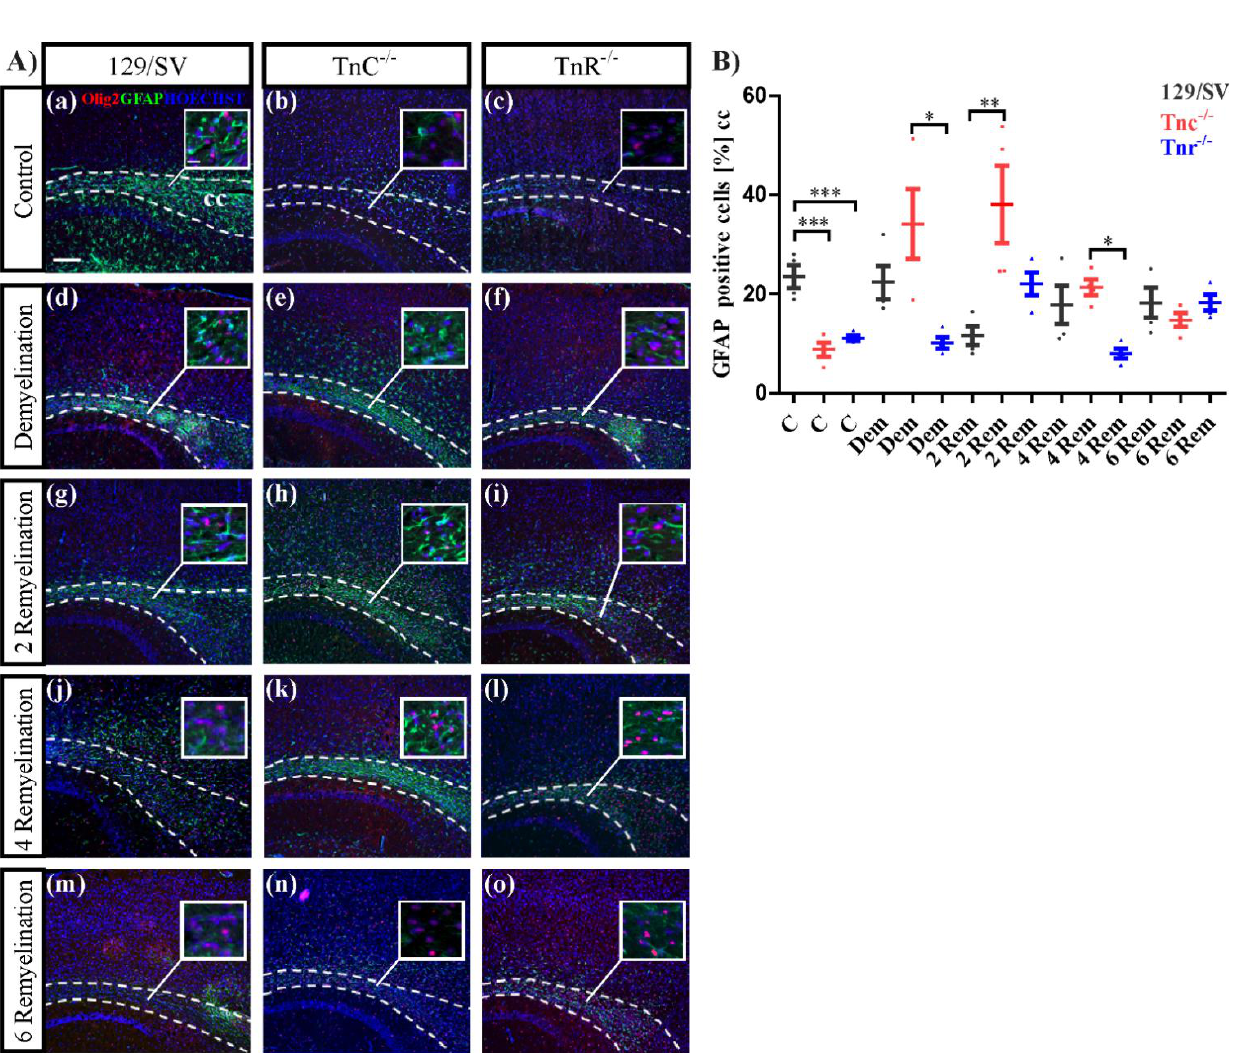
(C: SV/129: 8.9 ± 0.8%, C: Tnc −/− : 15.3 ± 1%, p = 0.001; C: Tnr −/− : 11.74 ± 0.9%, p = 0.0443)